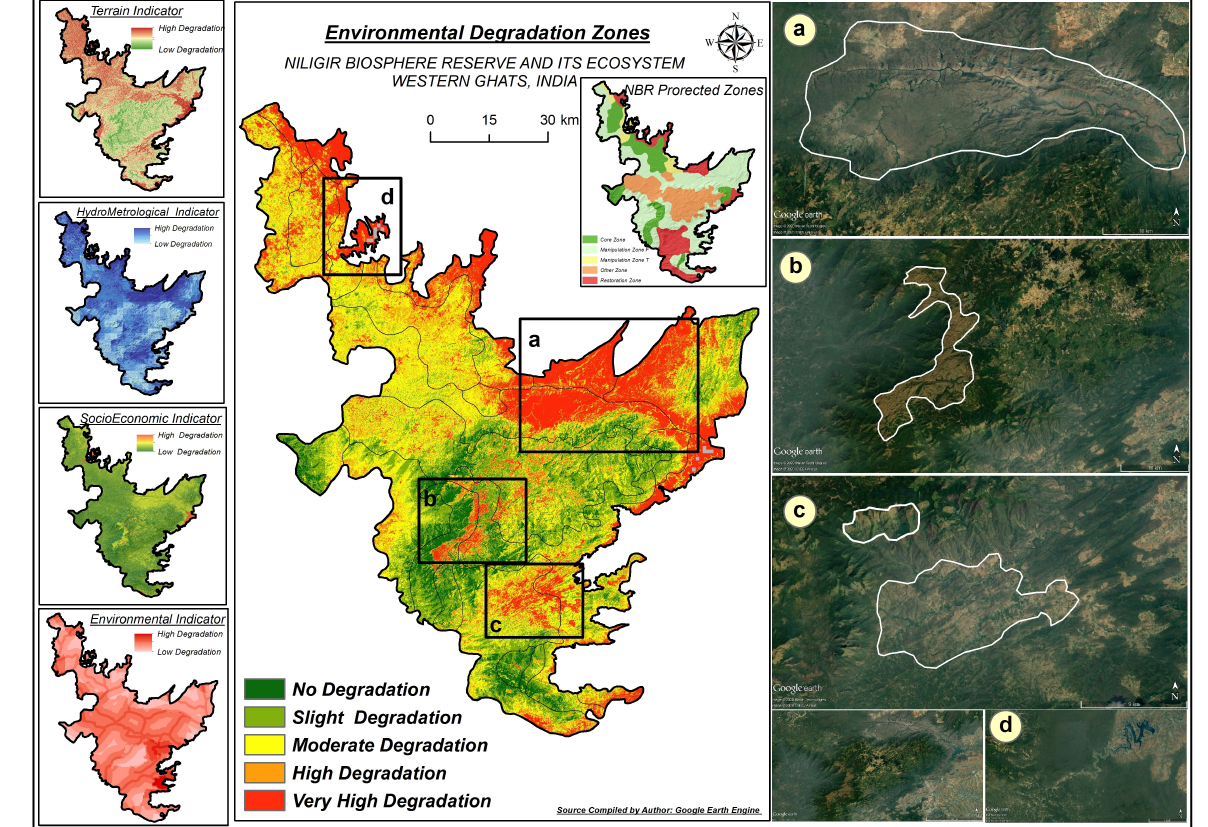
Figure 5. Distribution of Environmental Degradation